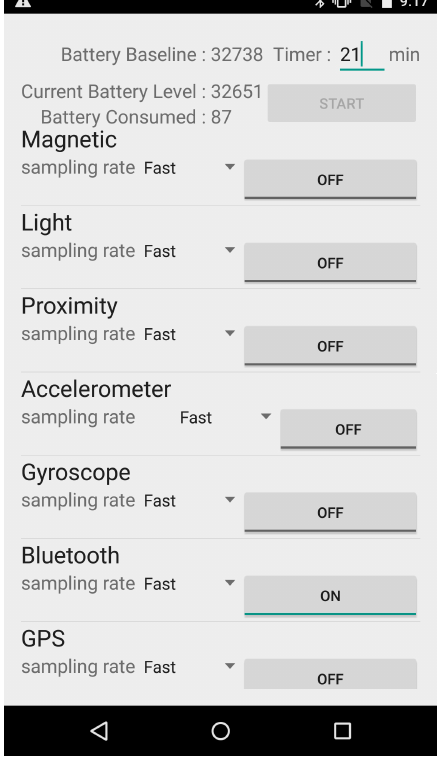
Figure 9. Screenshot of the power-monitoring app.